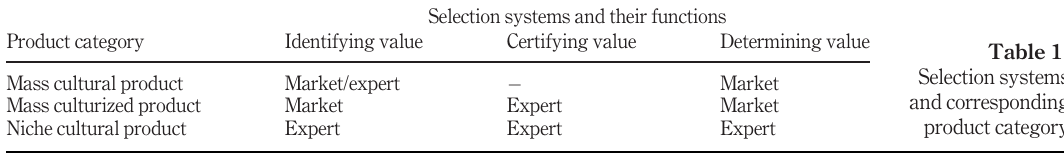
Table 1. Selection systems and corresponding product